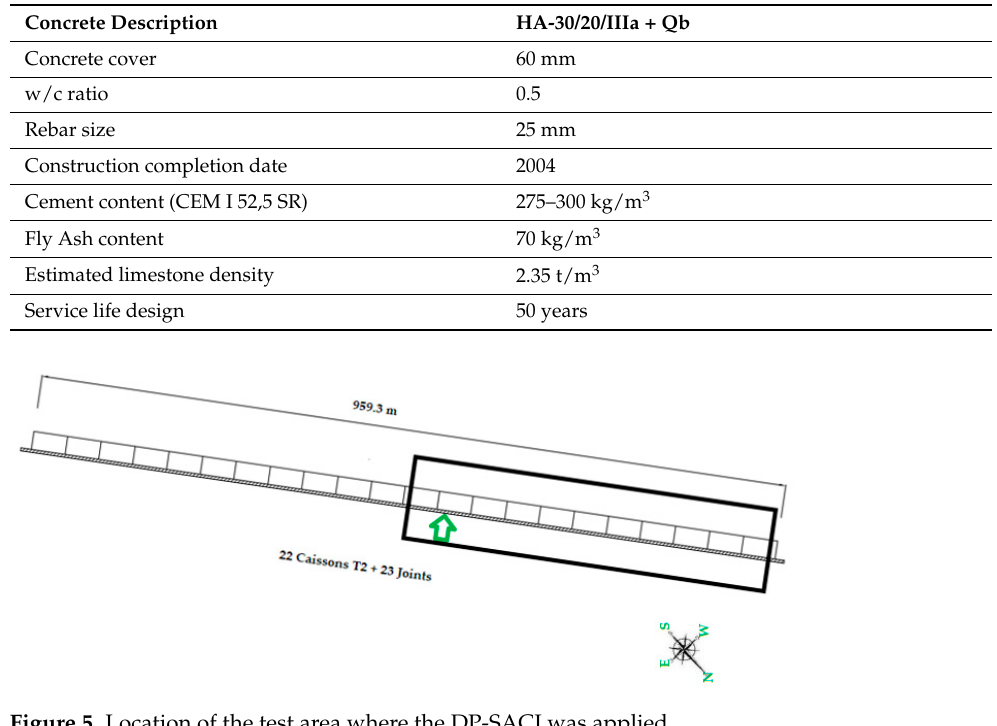
Figure 4. Elevation and section detail/drawing of the South West sea wall. Table 1. Concrete description and Service Life Design.